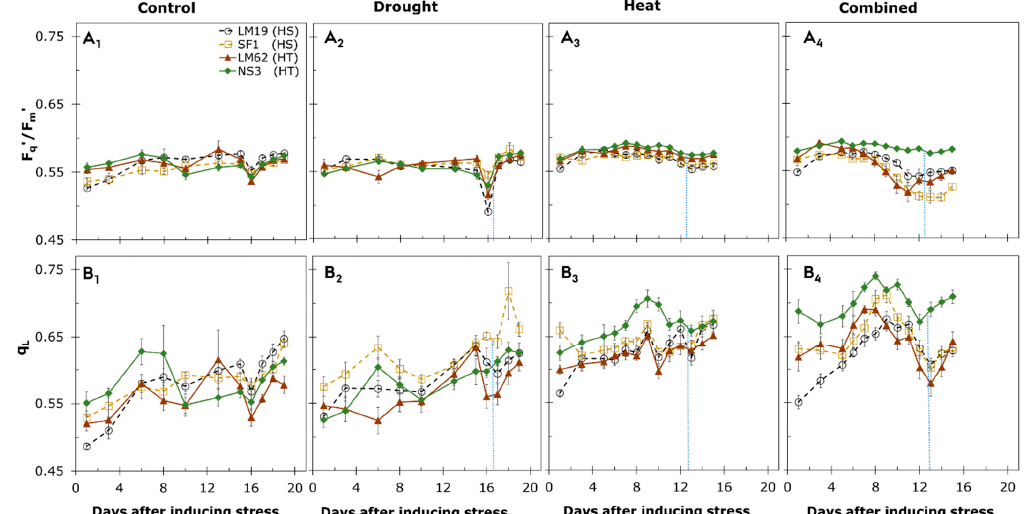
Figure 4. Chlorophyll fluorescence measurements on light-adapted plants at PPFD of 750 µ mol m − 2 s − 1 . ( A 1–4 ) PSII operating efficiency (F q ’/F m ’). ( B 1–4 ) Fraction of open PSII centers (oxidized Q A ) in steady state (q L ) at day 1 before inducing the stress and along days after inducing the stress treatments in four wheat genotypes. HS represents heat-sensitive genotypes and HT represents heat-tolerant genotypes. Blue dotted line denotes the recovery phase. The data represent mean values ± S.E.M ( n = 5).